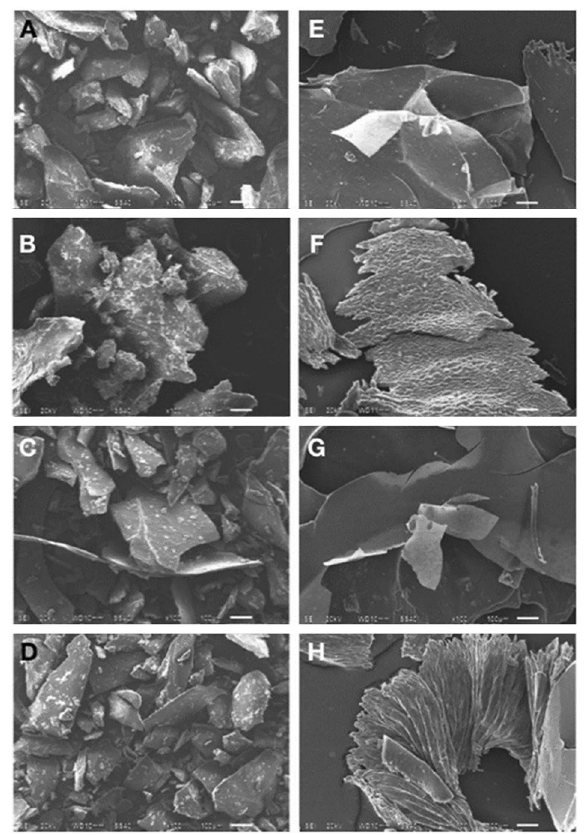
Figure 2. SEM images of tamarind seed pectin extracted, ( A ): Exp 1, ( B ): Exp 3, ( C ): Exp 5, ( D ): Exp 7, ( E ): Exp 2, ( F ): Exp 4, ( G ): Exp 6, ( H ): Exp